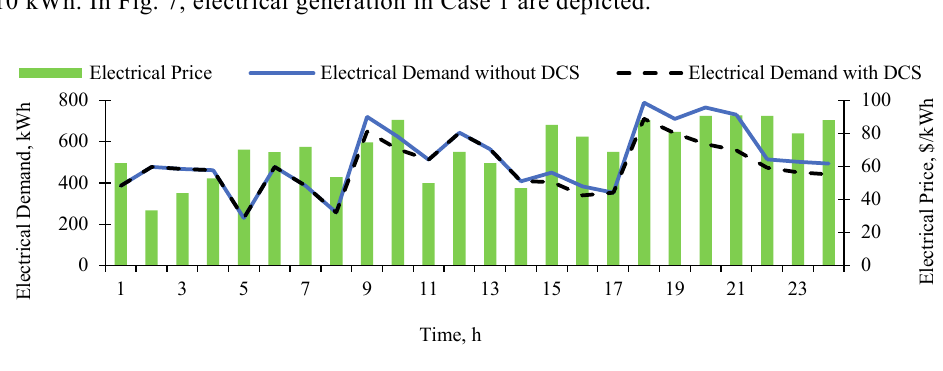
Fig. 6. Electrical demand with DCS and without